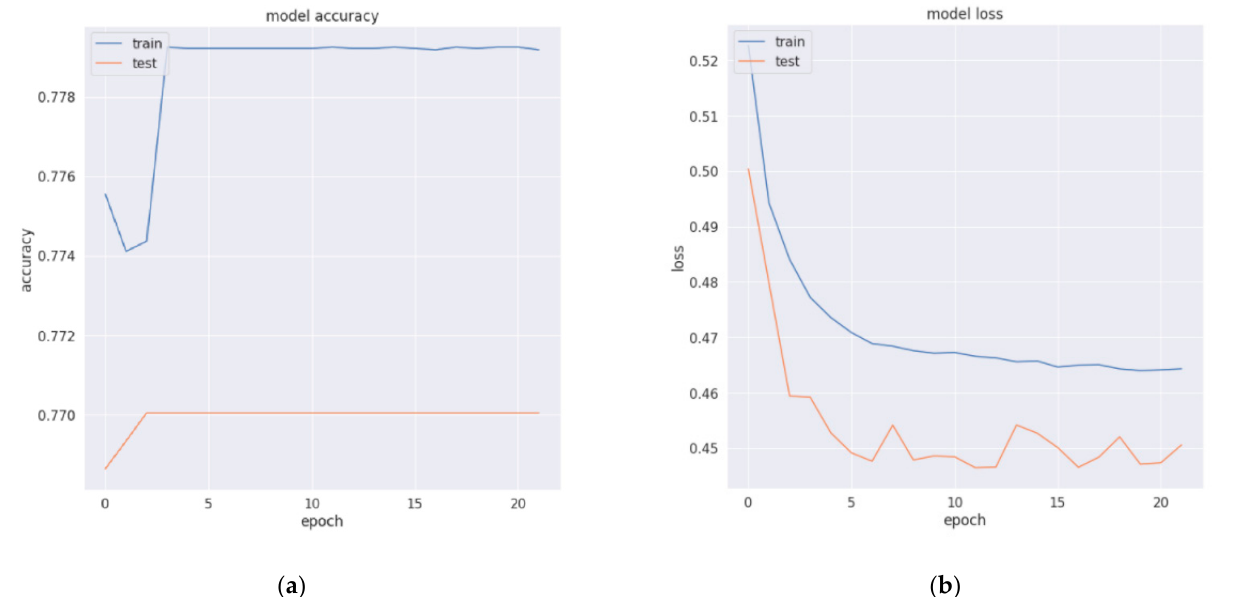
Figure 9. Long short term memory model ( a ) accuracy and ( b ) loss.